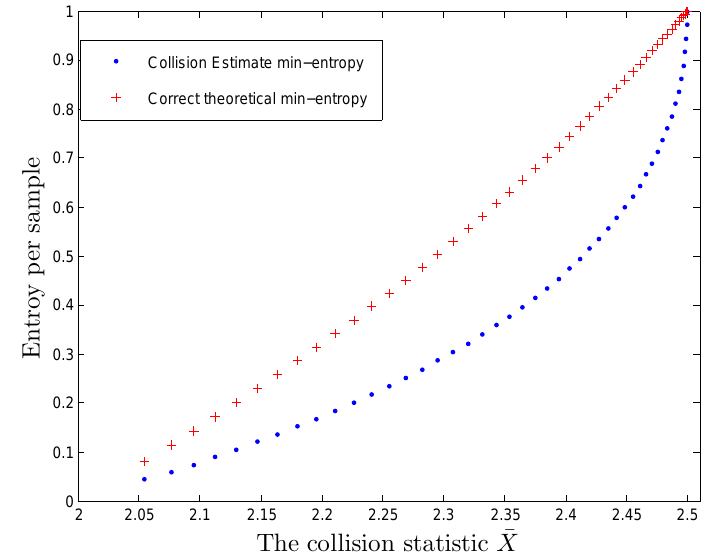
Figure 1: The comparison of min-entropy derived from Theorem 1 and the Collision